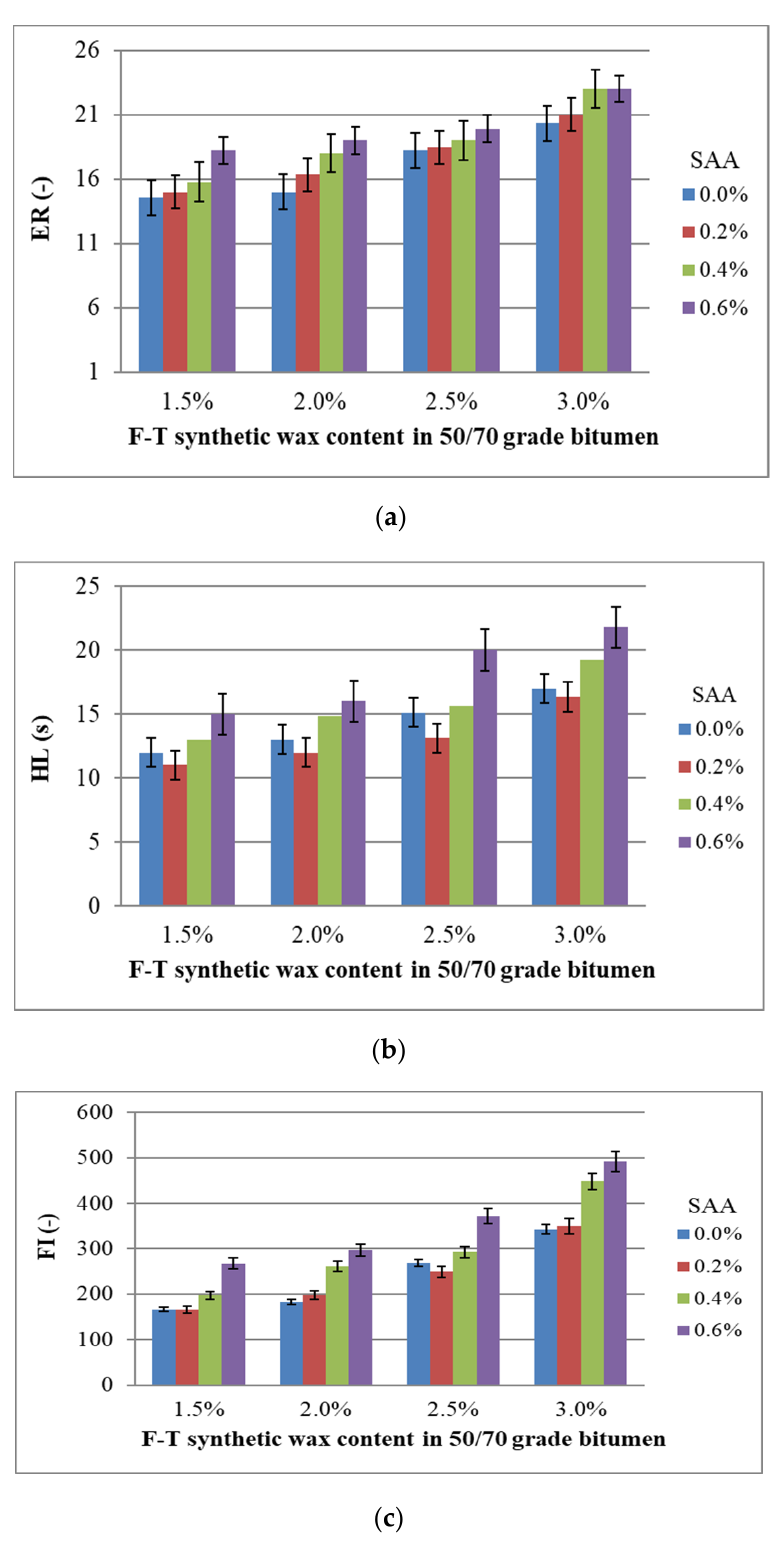
Figure 21. Bitumen 50/70 foam parameters for, ER ( a ), HL ( b ), FI ( c ). The use of F–T synthetic wax and SAA increases the bitumen 50/70 foam characteris- tics. An increase of nearly 80% is observed with the F–T wax content of 3.0%. The addition of SAA enhances this trend. As a result of using both additives, bitumen 50/70 has much higher foaming parameters than when either of the additives is used alone [18,20,36]. At 0.2% SAA, a decrease in HL of the bitumen foam is noted. This phenomenon may be caused by an adverse interaction of both additives and will be subject to detailed chemical analysis in the next stage of the research. In order to determine the dependence of the bitumen 50/70 foam parameters in terms of the additives used, a significance test was performed using the analysis of variance (ANOVA) and Statistica software [46]. The results show clearly that SAA and F–T wax content is a significant factor because the p-value is less than the assumed significance level α = 0.05. The results obtained for dynamic viscosity were used to develop a regression model. The values describing the model are summarized in Table 10.